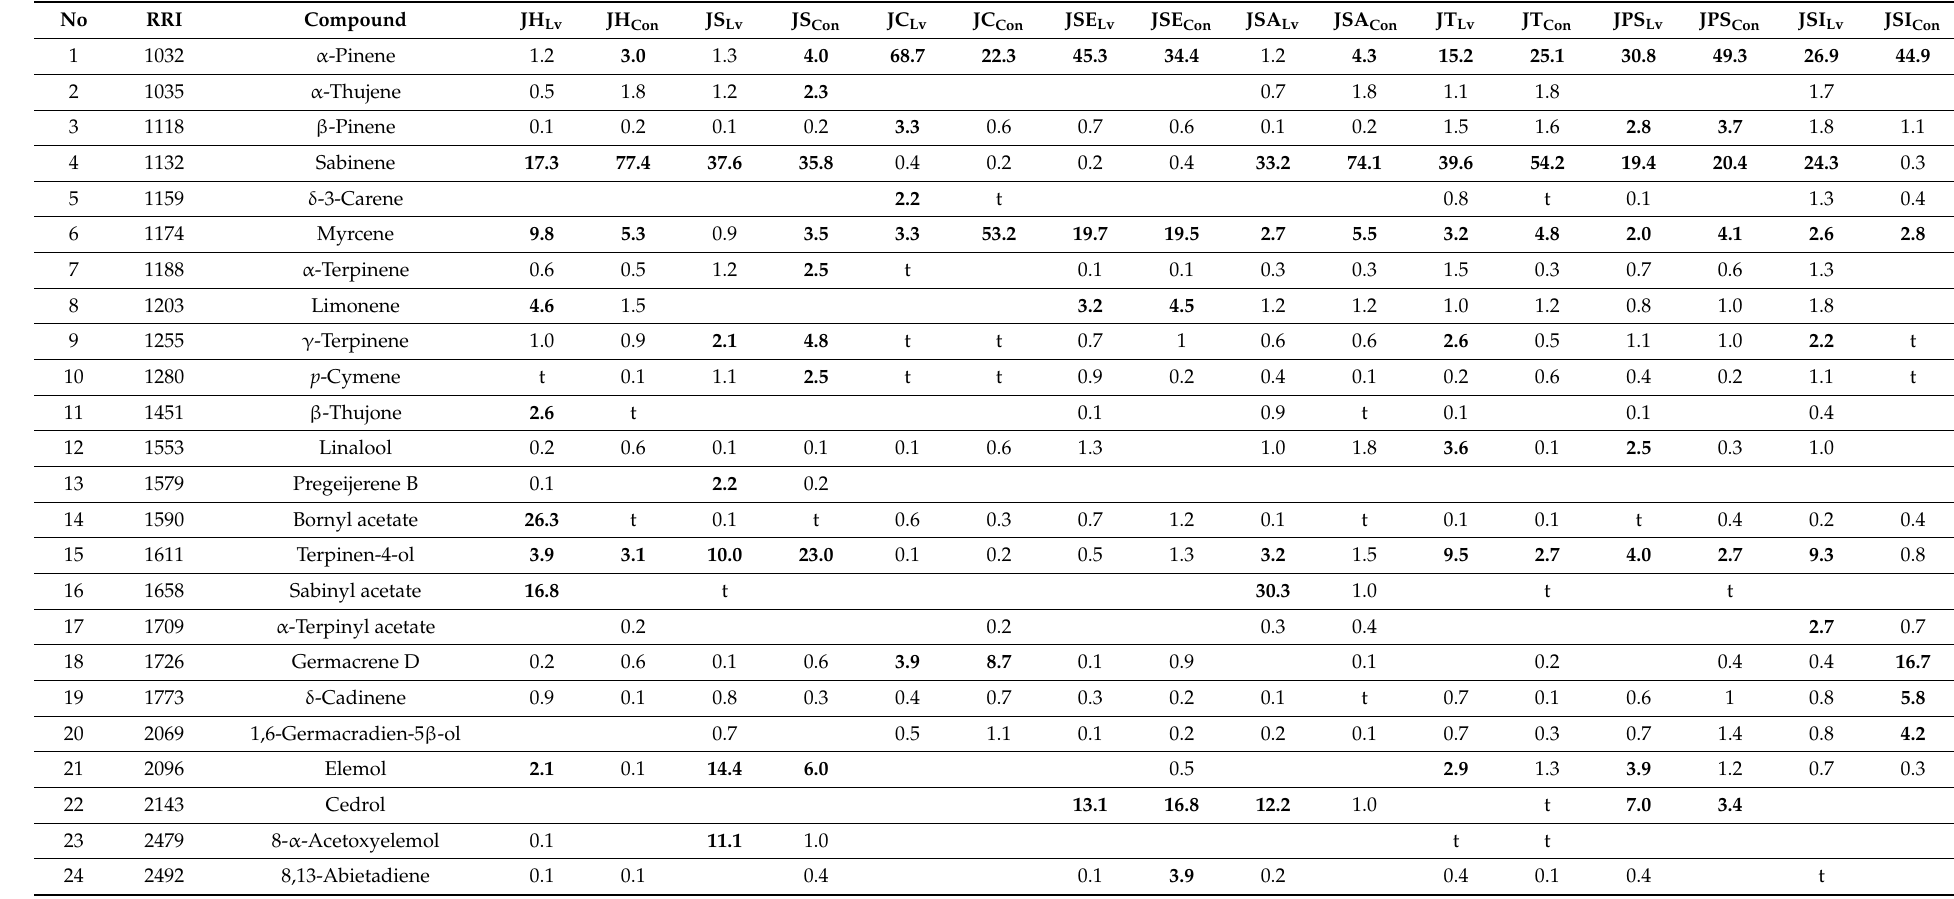
Table 2. Main compound components of essential oils (%) isolated from leaves and cones of different Juniperus